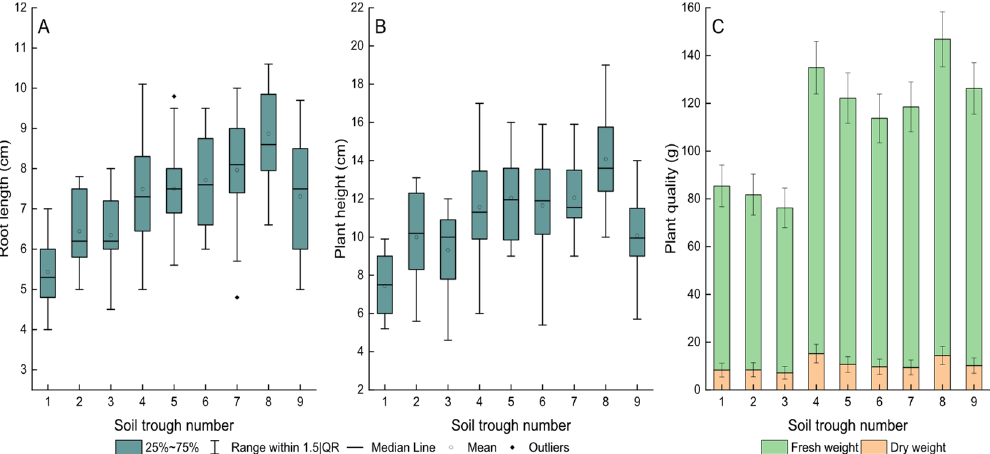
Figure 2. Root length ( A ), plant height ( B ), fresh weight, and dry weight ( C ) of pak choi in nine soil troughs. Table 2. LSD tests of growth indicators of pak choi under different fertilization schemes. Fertilization Schemes Mean Difference Pak Choi Growth Indicators Std. Error